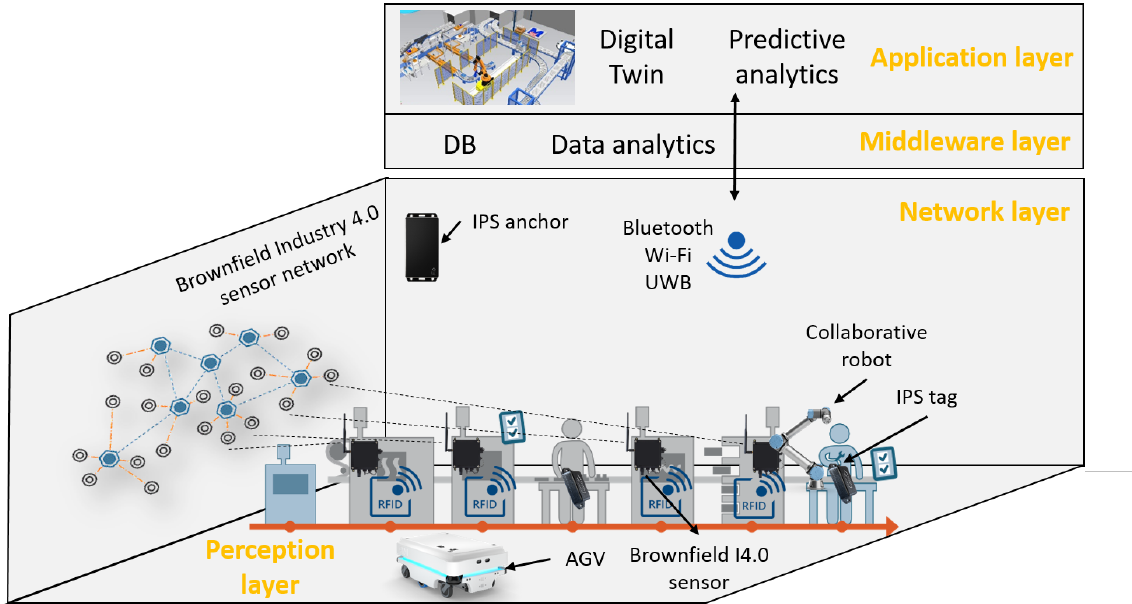
Figure 1. Extended intelligent space to obtain an education framework in a demonstration